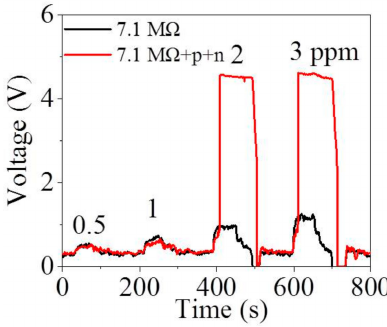
Figure 2. Output voltage of Mn-doped ZnO (MZO) to acetone from 0.5 to 3 ppm in the traditional electric circuit and the interlocking p+n FET circuit (R L is 7.1 M Ω ) under a humidity of 25%.